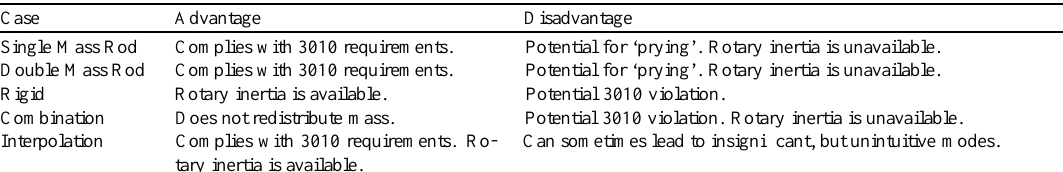
Fig. 14. Mode shapes for symmetric structure and asymmetric mass, continued. Table 9 Shock analysis results for other cases; Asymmetric